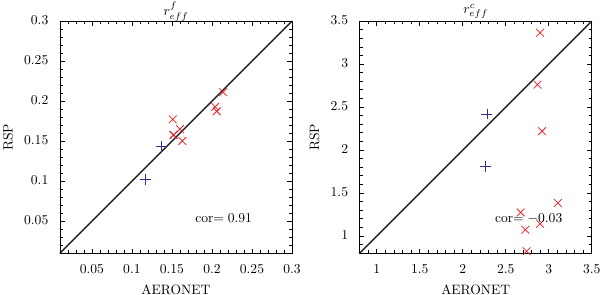
Figure 8. Comparison between the retrieved fine and coarse modes effective radius ( r f and r c ) of RSP measurements and eff eff AERONET. The correlation coefficients (cor) for each mode are in- cluded. Plus indicates cases where τ 675 < 0 .